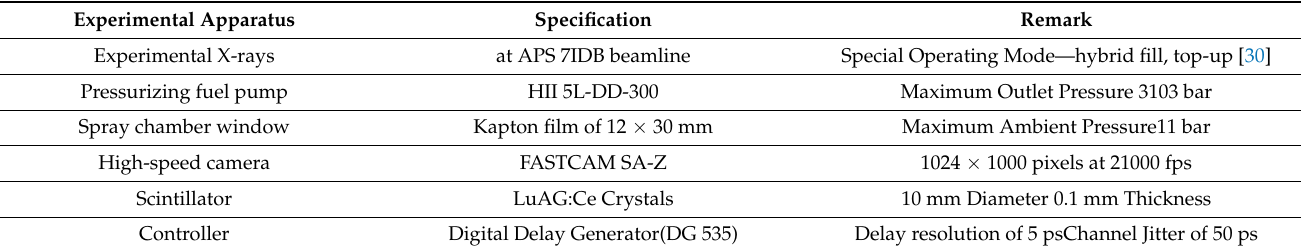
Table 1. Specification of the experimental